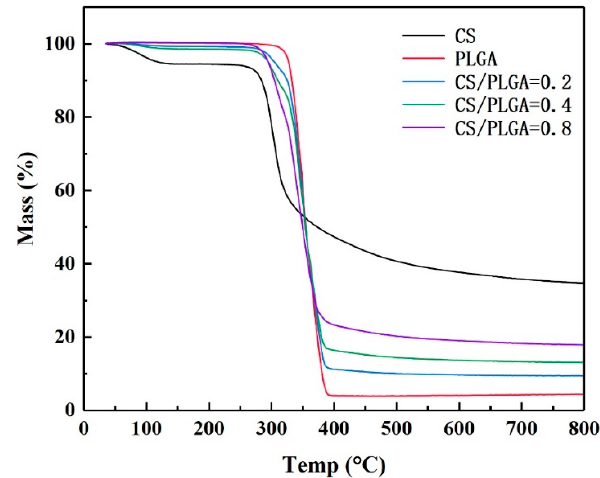
Figure 3. Thermal gravimetric analyzer (TGA) thermograms of NPs.